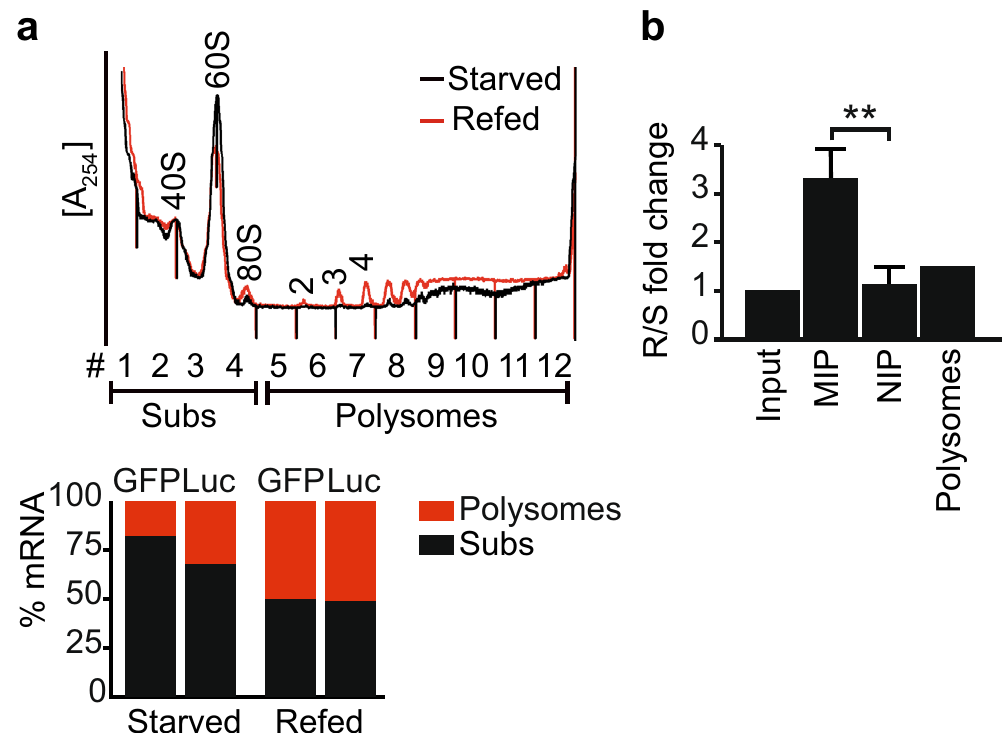
Figure 5. Detection of the translational response of an exogenous reporter mRNA in 1,000 human cells with R-MIPs. ( a ) The absorbance profile at 254 nm across a sucrose gradient is shown at the top, and the positions of the 40S and 60S ribosomal subunits, 80S monosomes, and polysomes are indicated. The black line represents a profile of co-transfected HeLa cells grown in serum-starved conditions (starved); the red line upon stimulation of the cells with serum (refed). The bar chart depicts the distribution of RPS6-GFP (left) and Luc control (right) mRNAs in subpolysomes (fractions 1–4) and polysomes (fractions 5–12) of starved and refed cells. RT-PCR data was normalised to a spiked-control RNA ( LysA ) added to each fraction prior to RNA isolation to adjust for technical variation during RNA isolation. ( b ) Bar chart depicting the changes of RPS6-GFP relative to Luc mRNA in refed (R) vs . starved (S) conditions in MIP/NIP eluates and in polysomes. RT-qPCR data was normalised to the respective mRNA levels in cell extracts (input) to adjust for variation in the transcriptome upon treatment of cells (see Methods). The change in polysomes was analysed upon pooling fractions 5–12 from the sucrose gradient shown in a . Error bars represent SEM, n = 3. ** P < 0.01, two-tailed homoscedastic student’s t